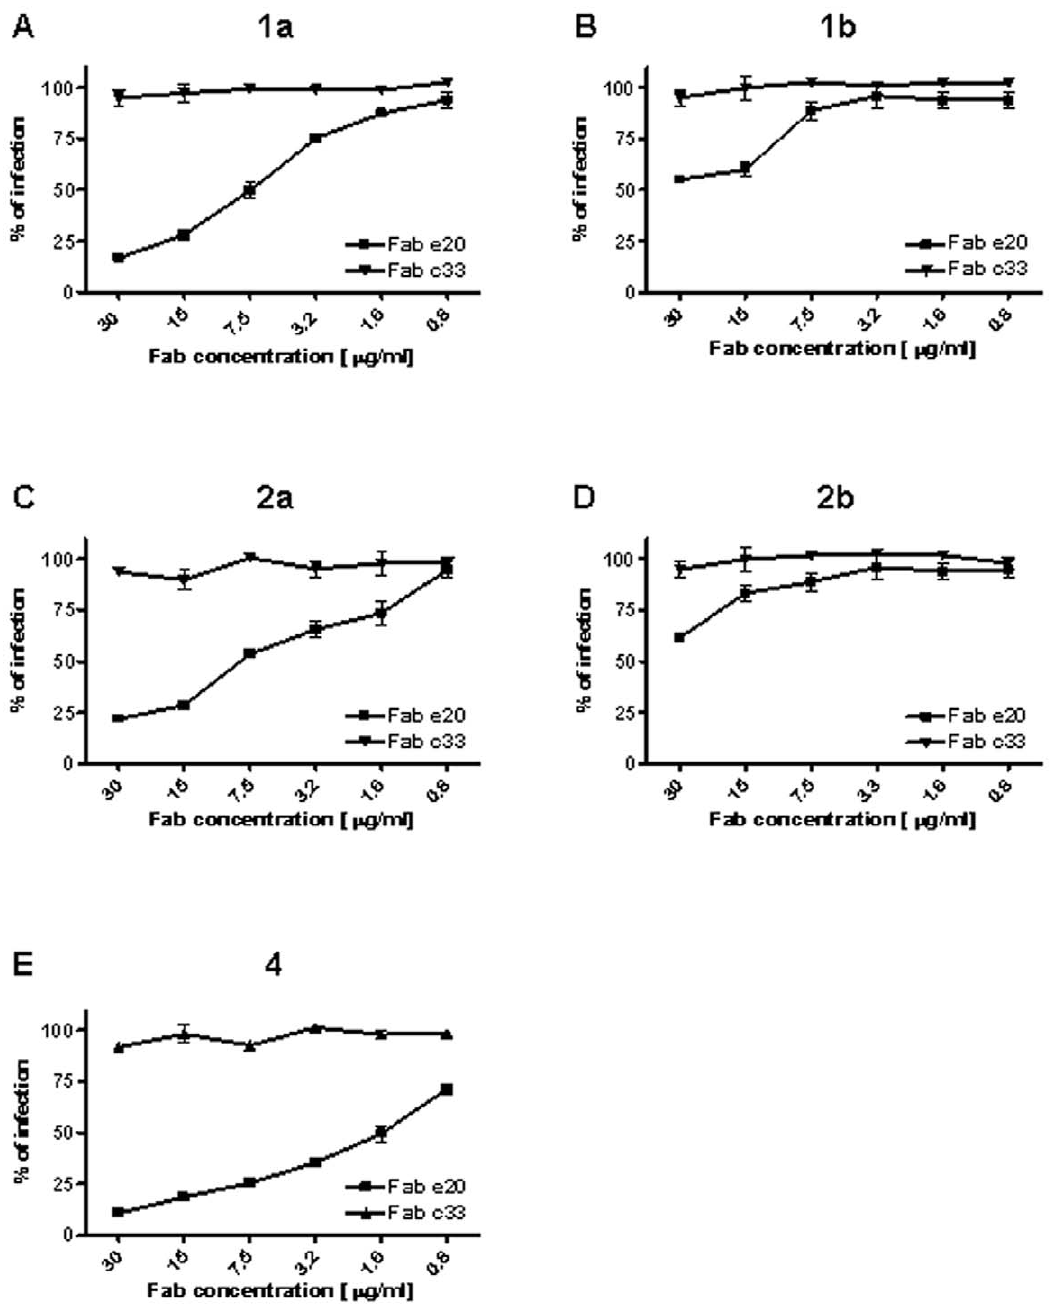
Figure 3. Neutralizing activity of Fab e20 using virus pseudoparticles (HCVpp). The following strains were used: genotype 1a UKN1A20.8 ( a ); E1E2 genotype 1b UKN1B5.23 ( b ); genotype 2a UKN2A1.2 ( c ); genotype 2b UKN2B1.1 ( d ); genotype 4 UKN4.21.16 ( e ). Data obtained from HCVpp infection in the presence of different concentrations of c33-3 (negative control) and e20 are presented as a percentage of the infection detected in the absence of antibody. The means and standard errors of two replicate assays are reported. HCVpp displaying genotype 3 (UKN3A1.28c) and genotype 6 (UKN6.5.8) did not give consistent signals in repeated assays, and were therefore not evaluated. No neutralizing activity was observed against genotype 5